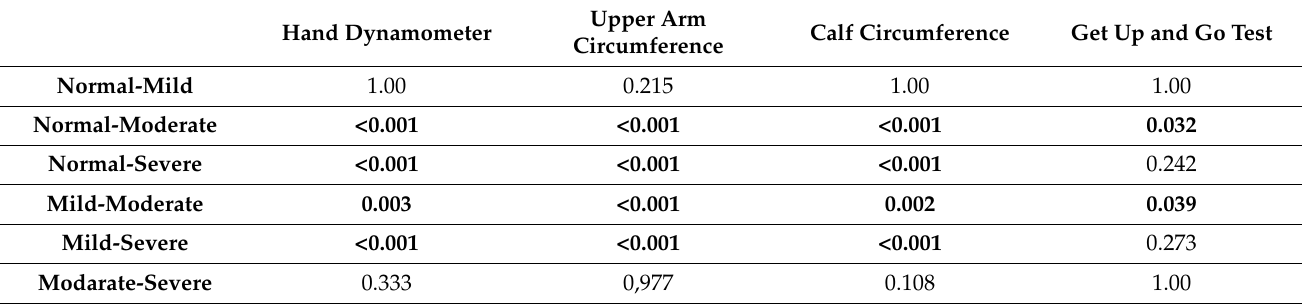
Table 3. Review of muscle measurements and muscle test features of the patients according to